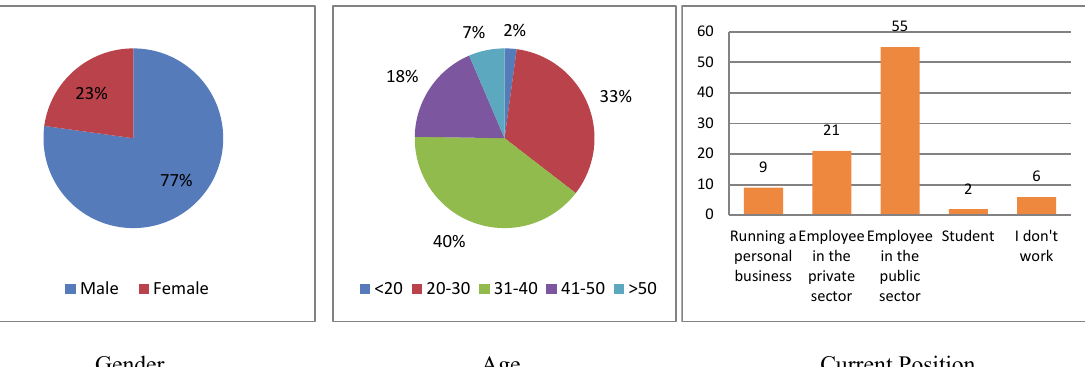
Fig. 1. Personal characteristics of the survey